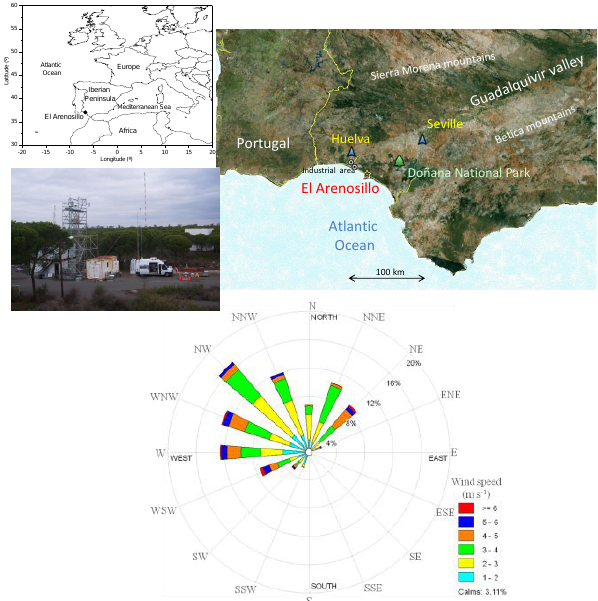
Fig. 1. Clockwise, from upper left: location of El Arenosillo in Europe; sites on the coast and in the Guadalquivir valley; wind rose for the measurement period; and the infrastructure installed for DOMINO